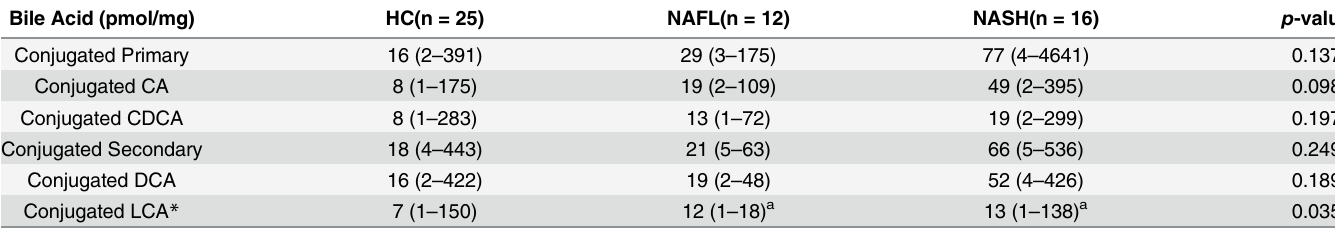
Table 3. Conjugated primary and secondary bile acid distribution in the study population ( n = 53).